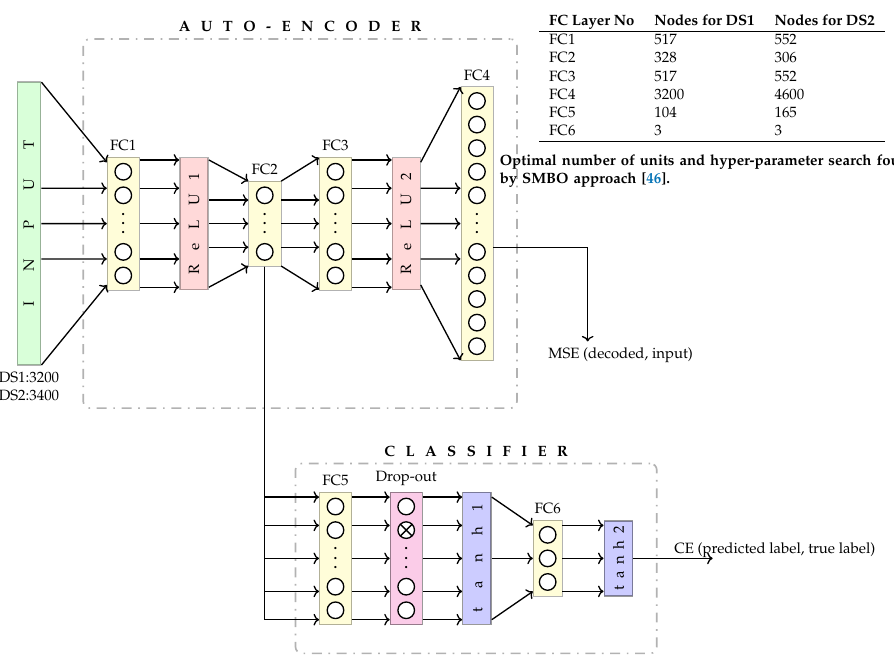
Figure 6. Deep Classifier AutoEncoder (DCAE) architecture with optimal number of units and hyper-parameter search found by SMBO approach [46]. * Fully Connected Layer (FC4): A fully connected layer that performs a linear transformation which decode 517 encoded inputs to 3200 decoded inputs for DS1, and decode 551 encoded inputs to 4600 decoded inputs for DS2. The output of FC4 is the output of the decoder. The error between the decoded inputs, and the inputs from DS1 (or DS2) is computed using 375 mean square error (MSE).